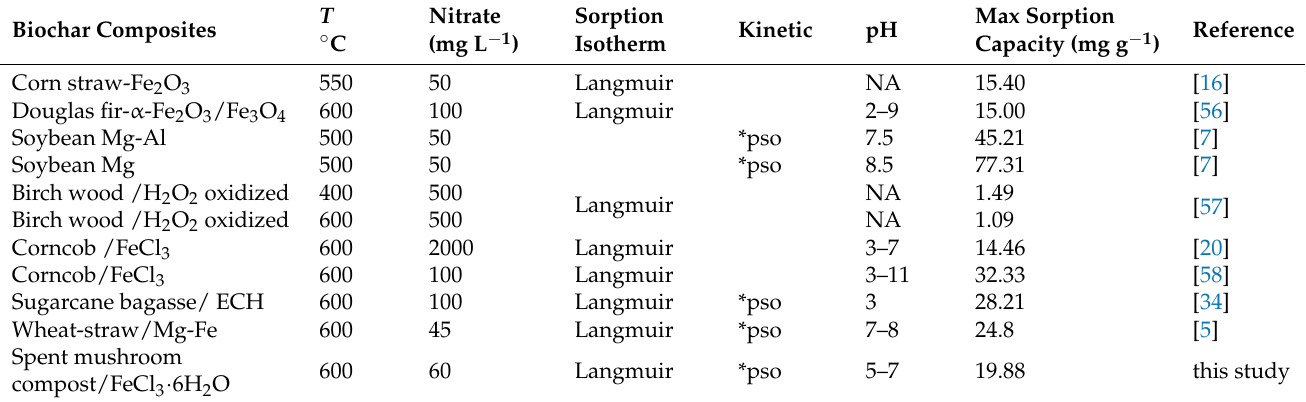
Table 3. Removal of nitrate contaminants from aqueous solutions by biochar-supported metal nanoparticles.